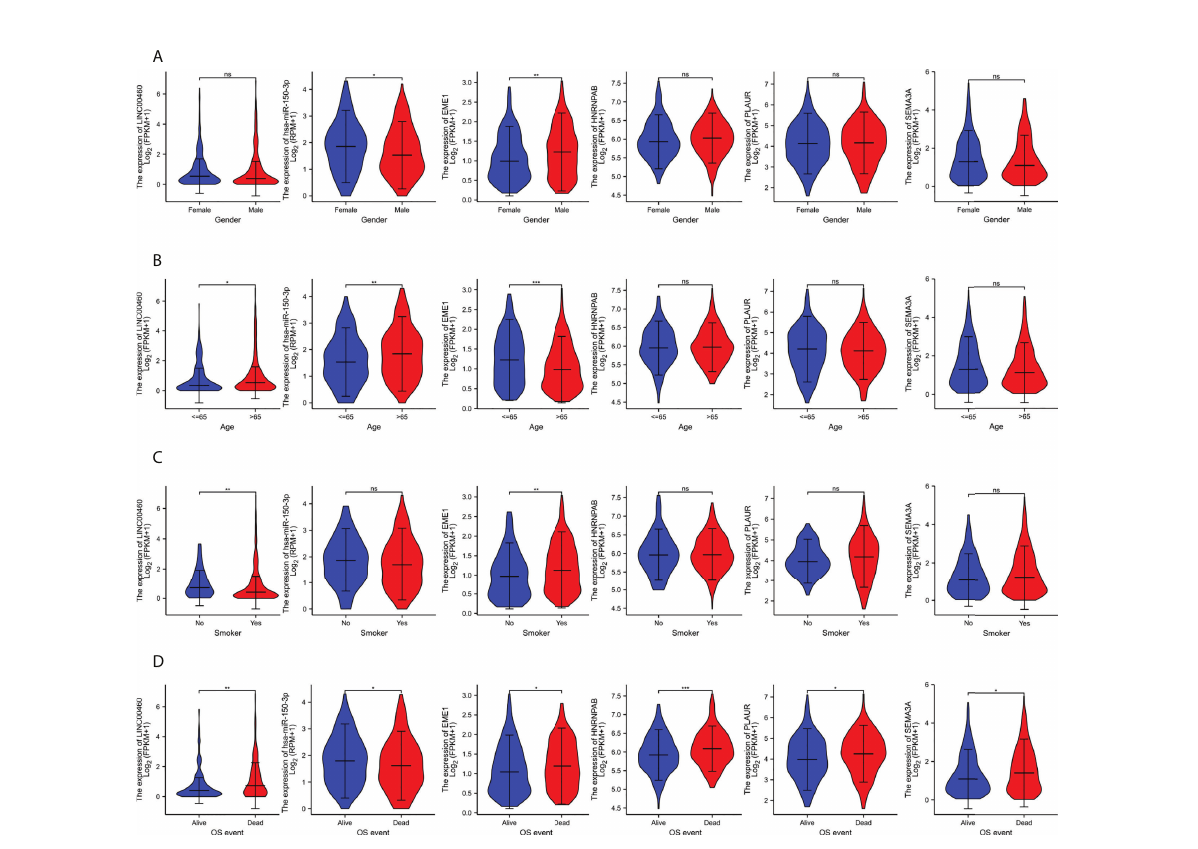
FIGURE 8 The clinical relevance of predicted target genes in LUAD Patients. (A) EME1. (B) HNRNPAB. (C) PLAUR. (D) SEMA3A. ns, no signi fi cant; *p < 0.05; **p < 0.01; ***p <